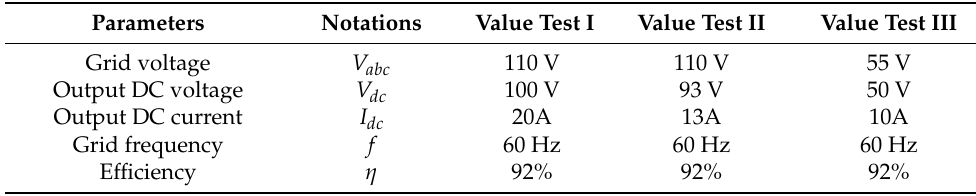
Table 2. Experimental parameters.